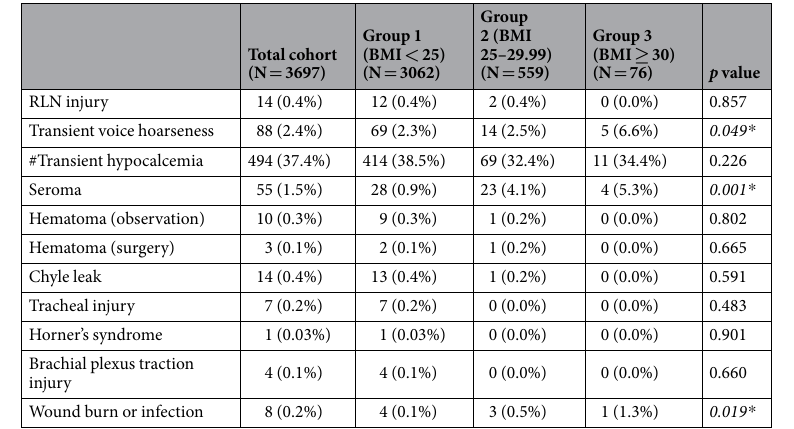
Table 2. Complication rates for the three BMI groups. BMI, body mass index in kg/m 2 ; RLN, recurrent laryngeal nerve; # Bilateral total thyroidectomy patients only (N = 1320); * statistically significant at p < 0.05.